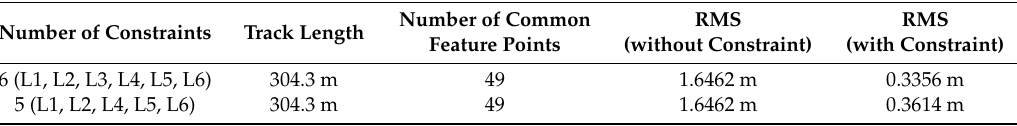
Table 3. RMS of adding all existing distance constraints and RMS of adding distance constraints of Delaunay triangulation